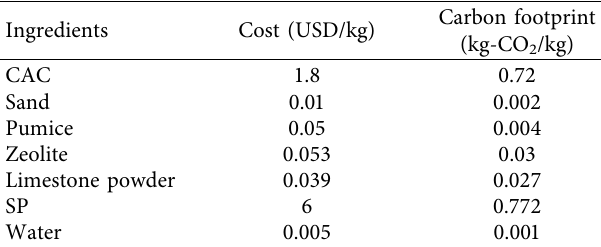
Table 5: Database used for unit cost and carbon footprint of raw materials.